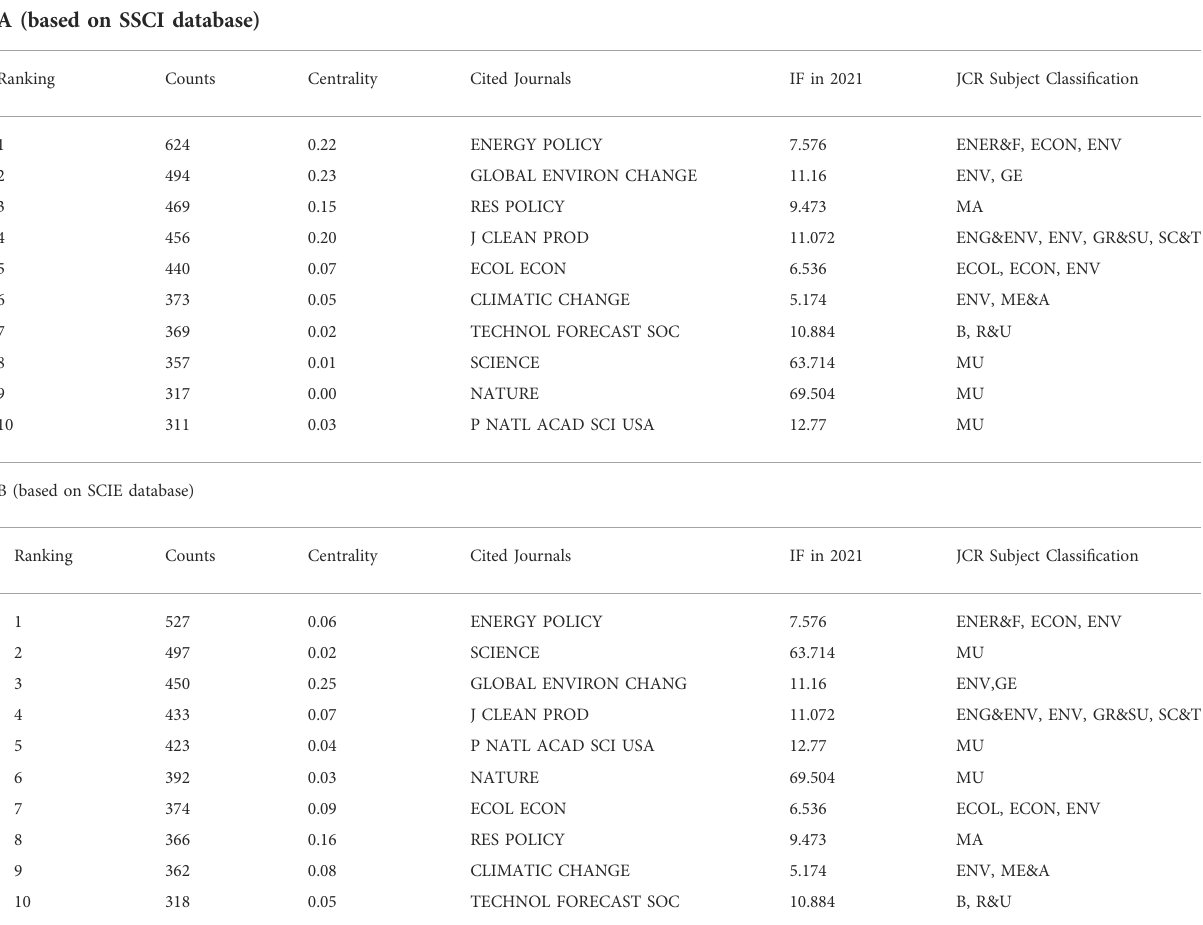
TABLE 5 Top 10 most cited core journals on climate